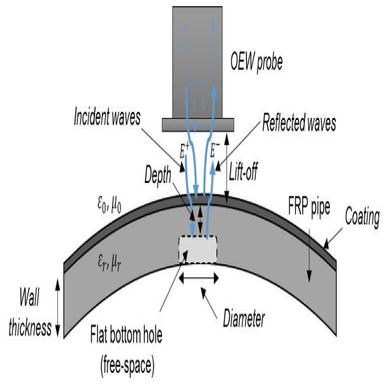
Microwave Open-ended Waveguide for GFRP pipe scanning.